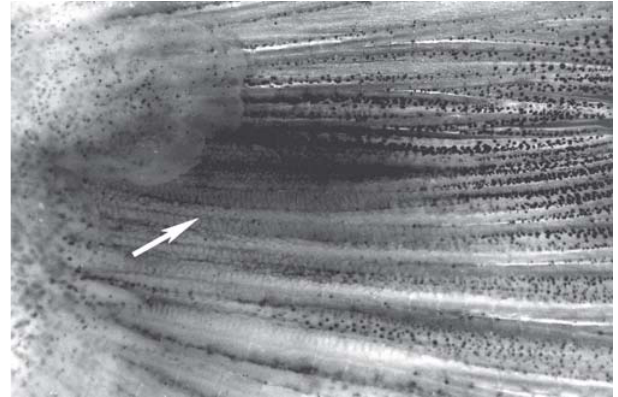
Fig. 23. Glandulocauda caerulea , adult male, USNM 326756, 43.9 mm SL; detail of caudal organ of adult male showing beaded glandular tissue indicated by arrow. Lateral view, left